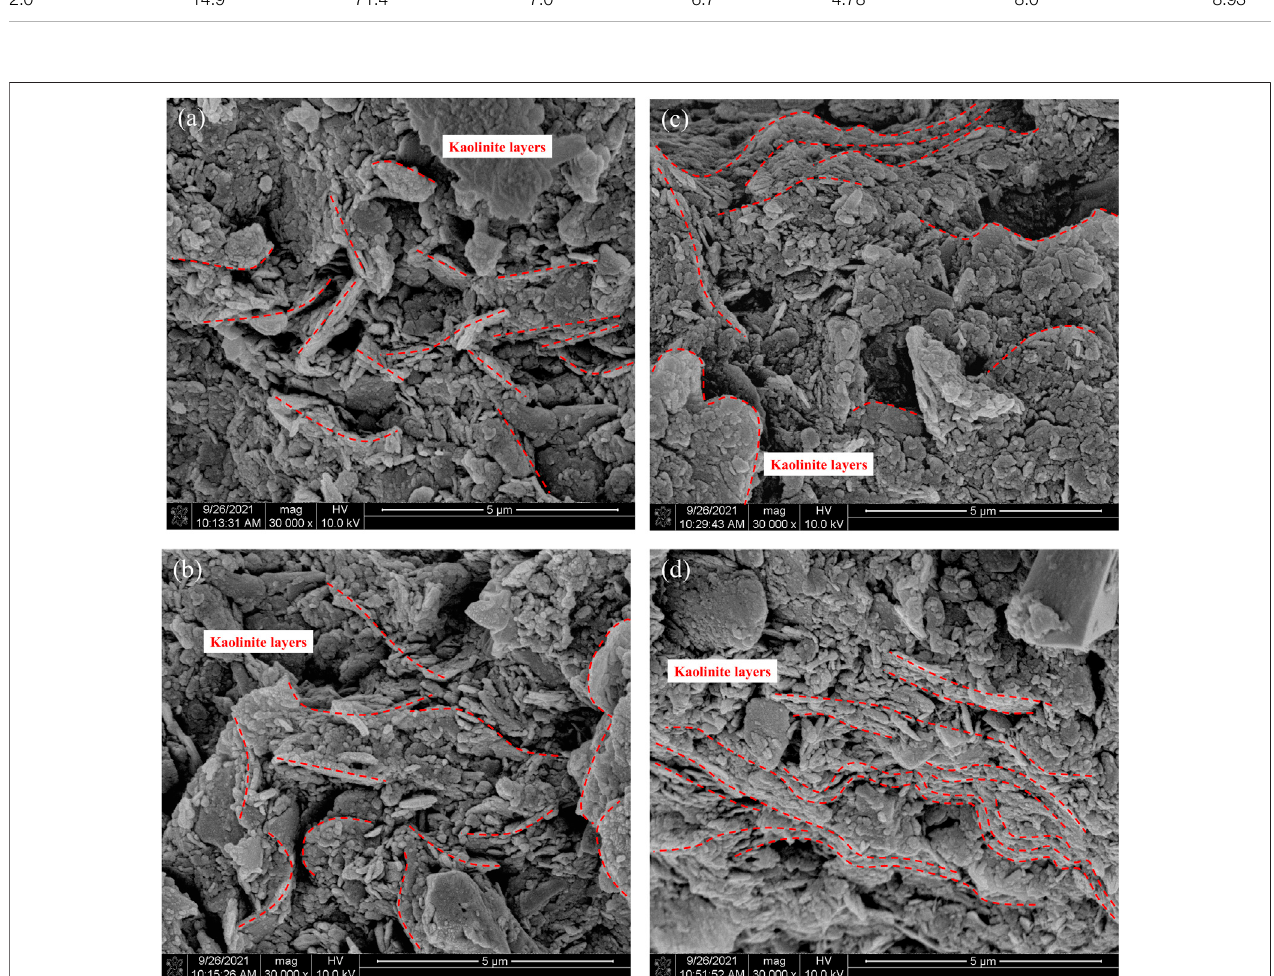
FIGURE 3 | SEM micrographs of residual soil at different depths. (A) Depth=0.5 m. (B) Depth=1.0 m. (C) Depth=1.5 m. (D) Depth=2.0 m.